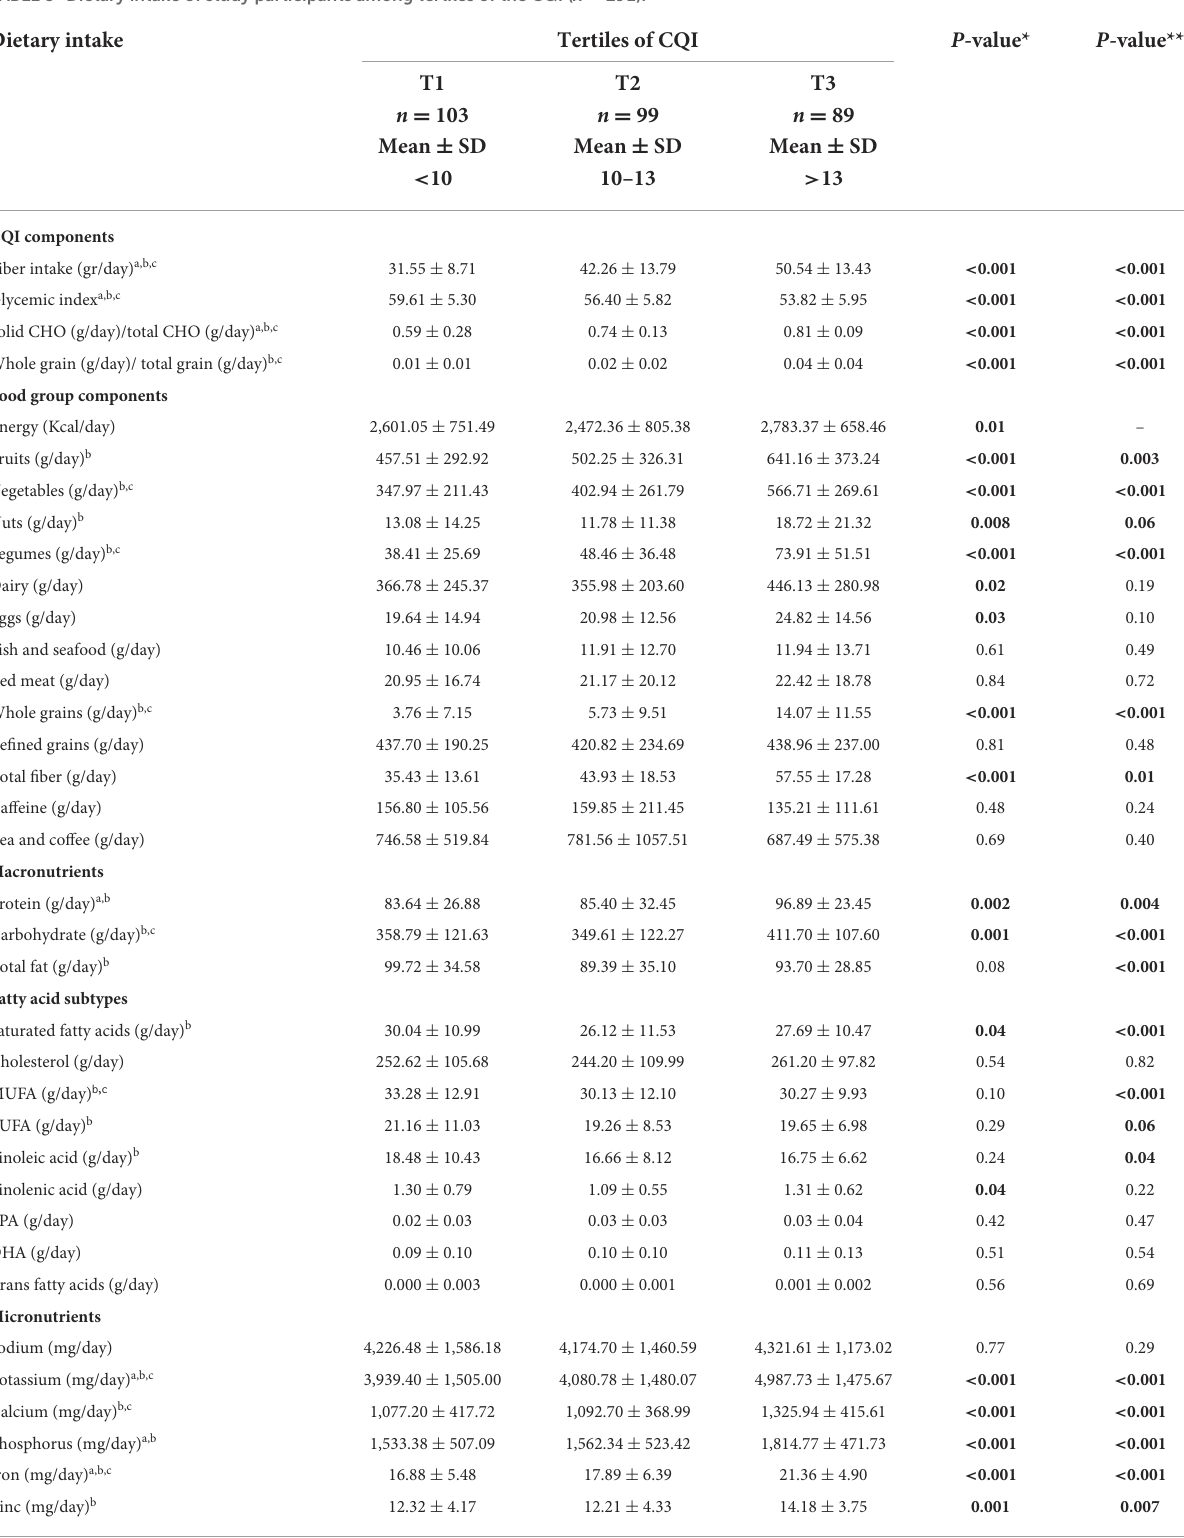
TABLE 3 Dietary intake of study participants among tertiles of the CQI ( n =